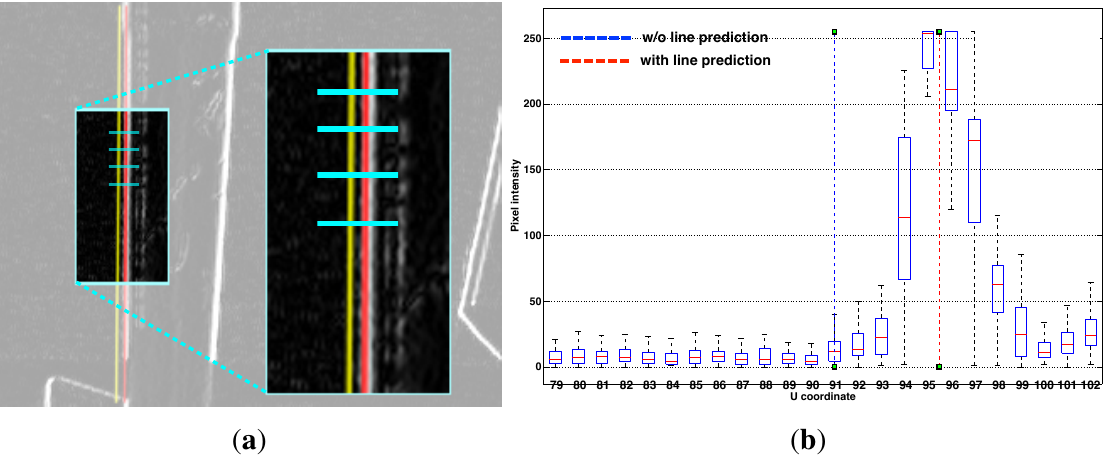
1 − 1 (with prediction −